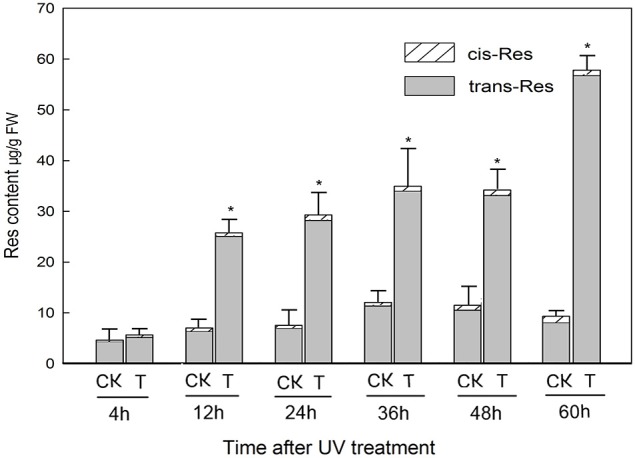
Resveratrol (res) content of grapevine Vitis amurensis cv. Tonghua-3 berries at various time points after UV-C irradiation. Each block denotes the mean value for each time point and treatment (n = 3), bars represent the standard error. Asterisks indicate significant differences between UV-C treated (T) and untreated control (CK) samples from the same time point (*P < 0.05, Paired t-test).